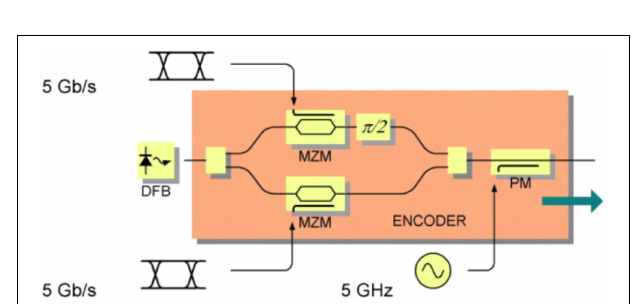
FIGURE 19 | 7-core-fiber silicon photonics receiver. The upper right figure shows a photograph of the fiber cross section, showing the seven cores. The top shows the schematic for each channel in the silicon photonic